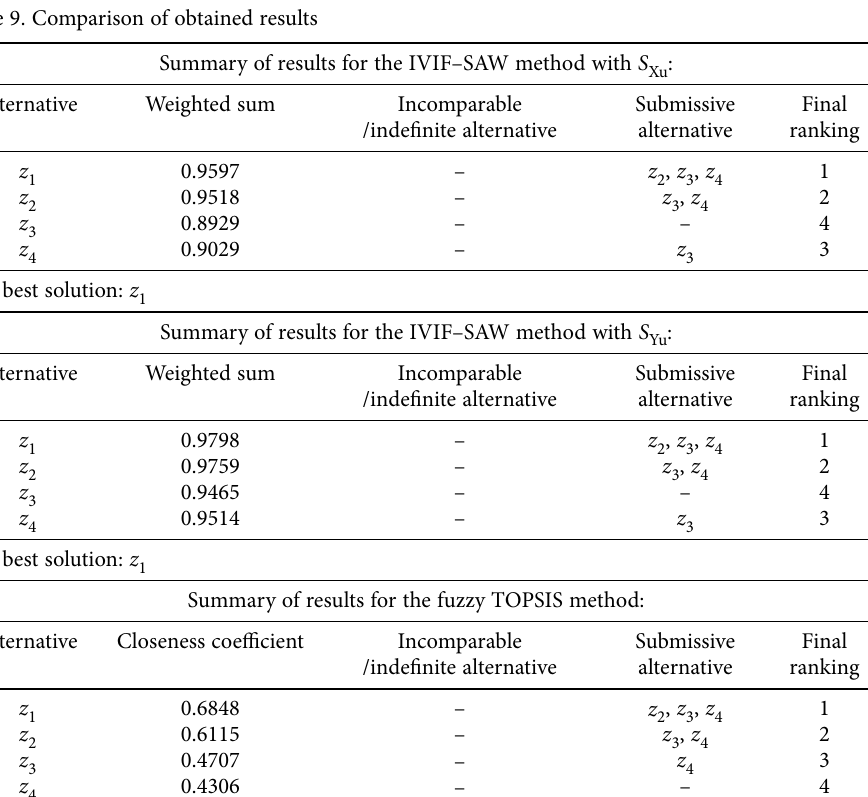
Table 9. Comparison of obtained results Summary of results for the IVIF–SAW method with S